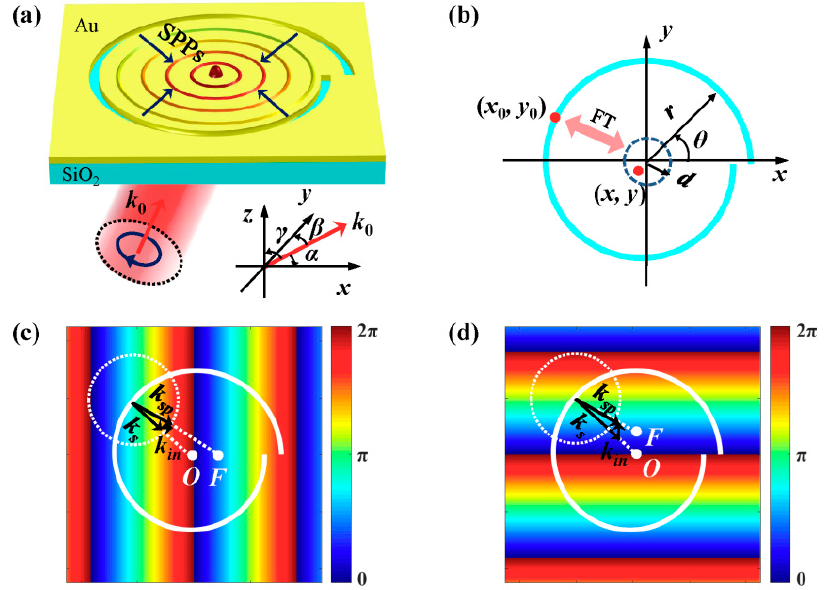
Figure 1. ( a ) Schematic diagram of a plasmonic lens illuminated by obliquely incident light. ( b ) presents the FT relation between the SPPs’ field along the Archimedes spiral slit and the SPPs’ field near the origin. ( c , d ) schematically show the linear gradient phase imprinted on the excited SPPs and the displacements of SPPs’ focus.